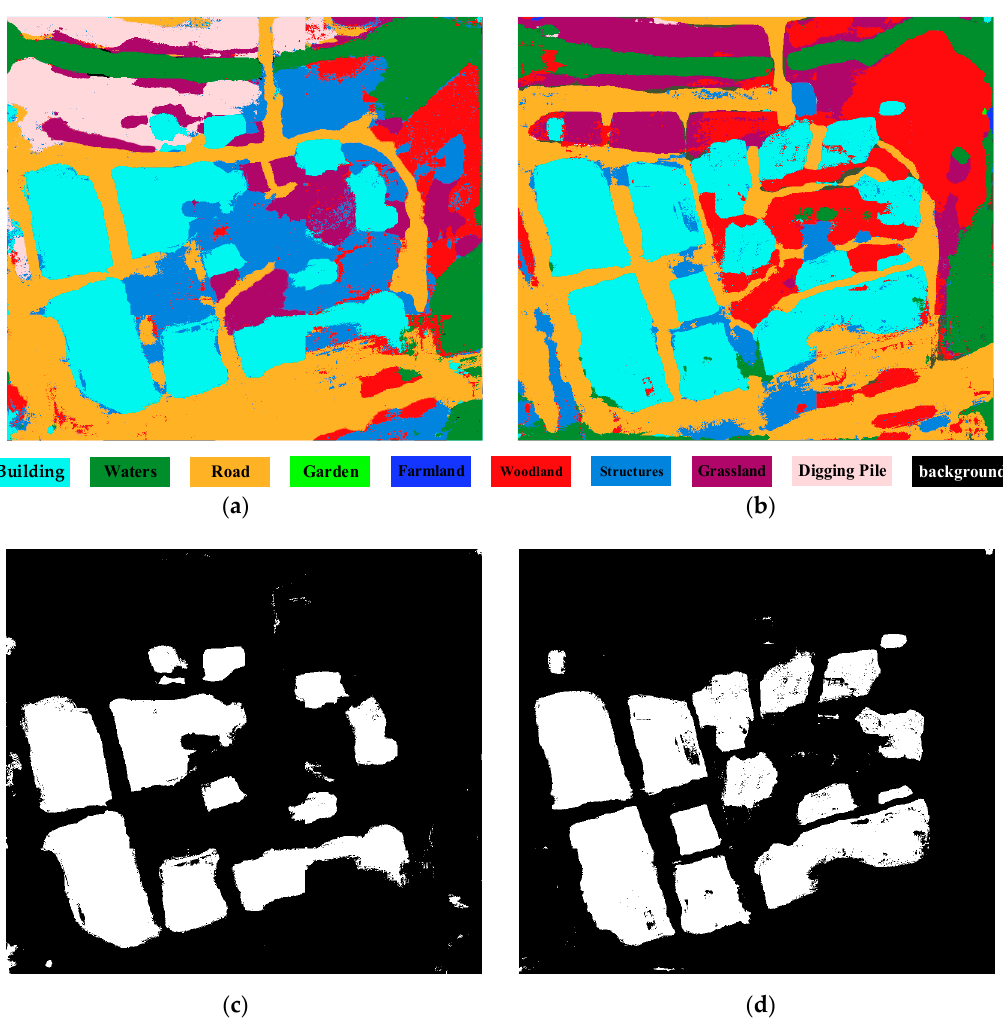
Figure 5. Results of sematic segmentation and building extraction. Sematic segmentation for the aerial image at ( a ) time t 1 and ( b ) at time t 2 ; sematic building label for the aerial image at ( c ) time t 1 and ( d ) at time t 2.